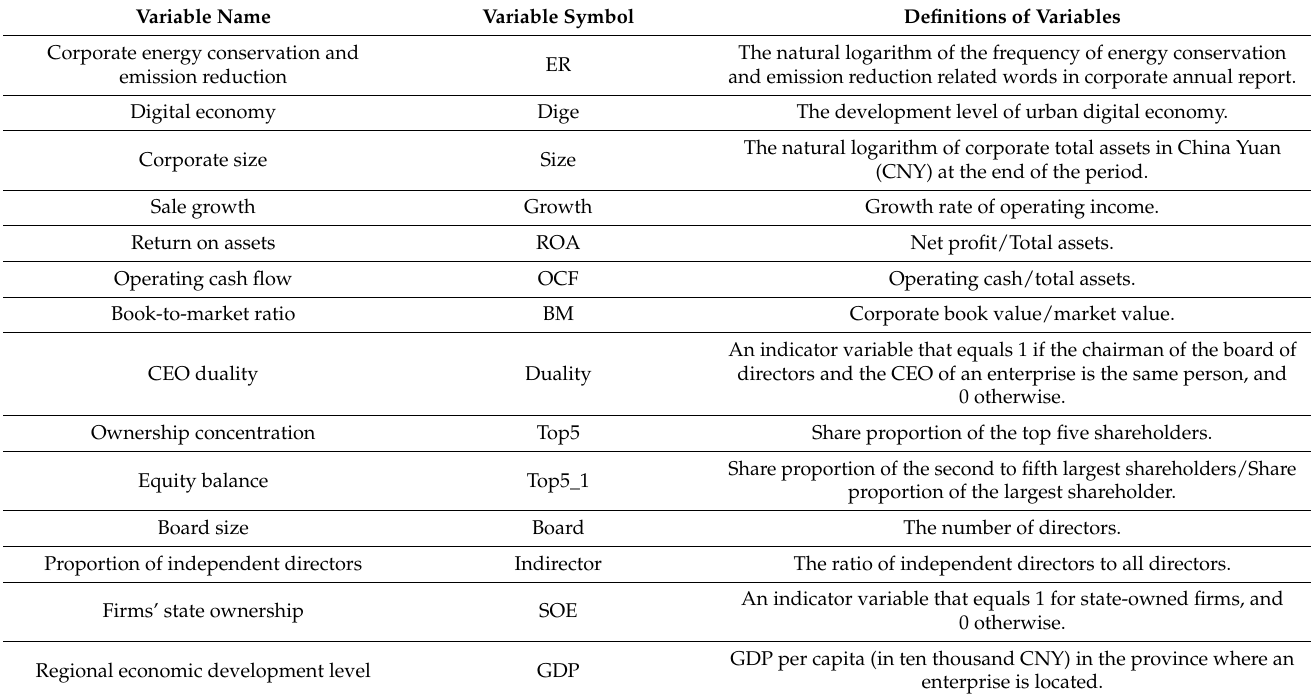
Table 1. Definitions of related